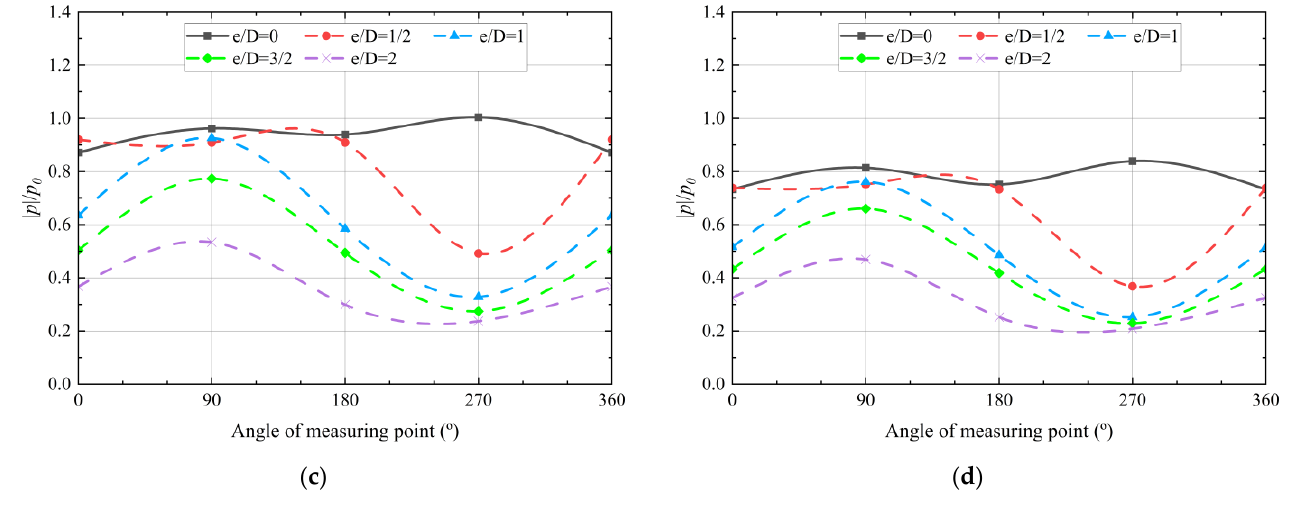
Figure A2. Variation of the dimensionless pore pressure amplitude around the pipeline with different backfill depths and current conditions ( 𝑈 𝑐 = ± 0.1 m/s, ± 0.2 m/s). ( a ) 𝑈 𝑐 = 0.1 m/s; ( b ) 𝑈 𝑐 =